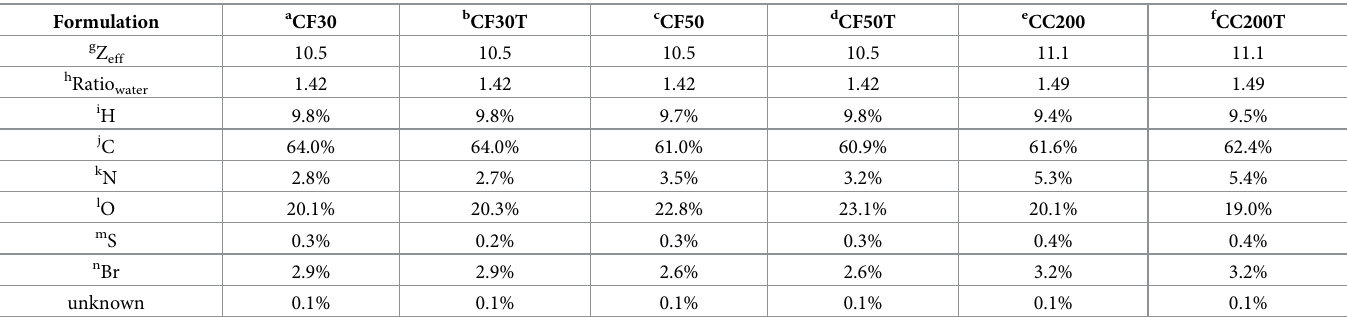
Table 2. Elemental composition analysis results of the XRF measurements for all formulations.